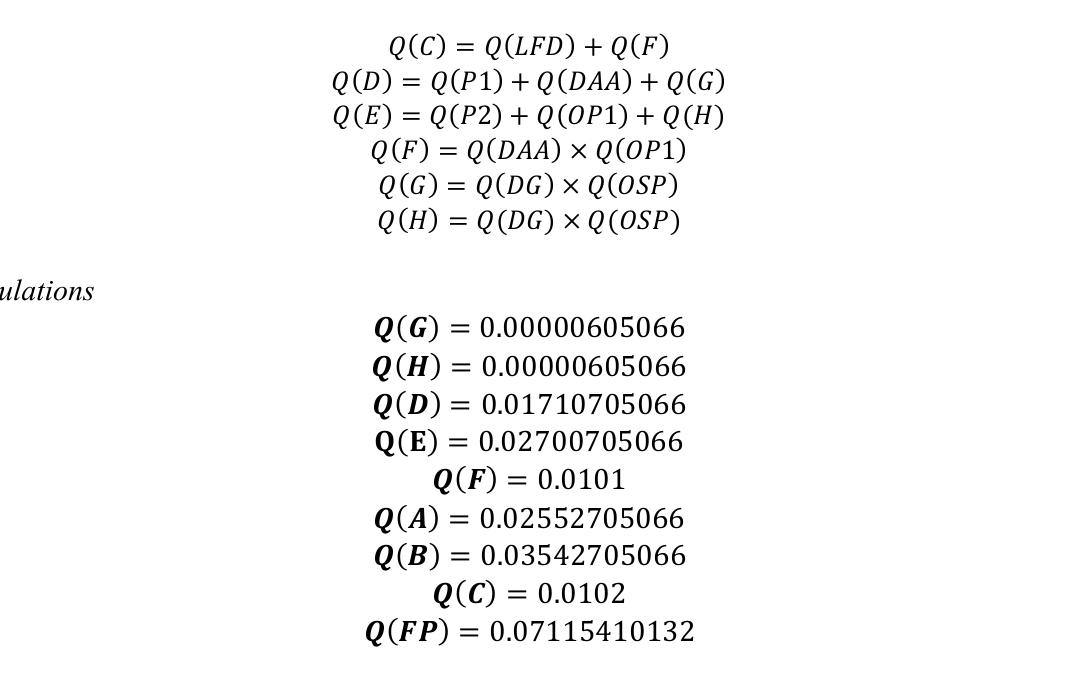
Table 6. Values of the probability of failure and success of the system components System R(t) Q(t) MTTF [2] OSP 0.99989